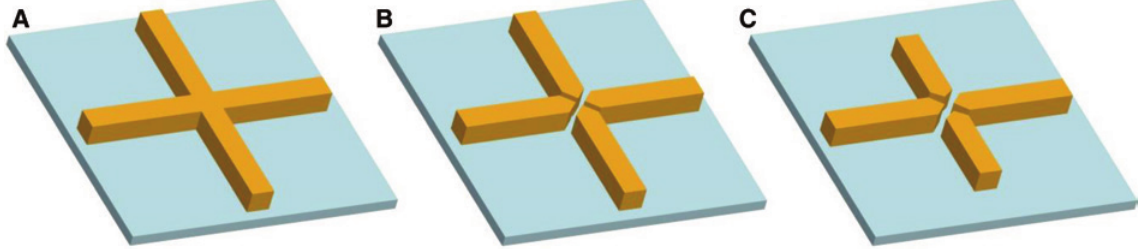
Figure 8: Various cross structures used for SEIRS.